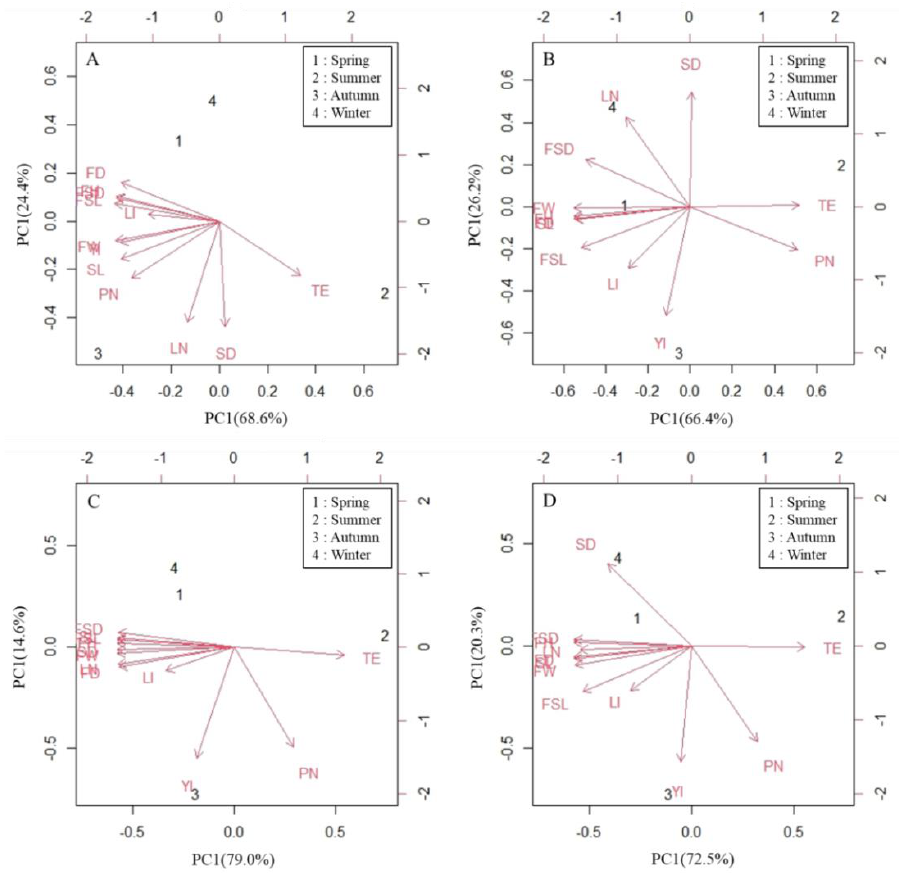
Figure 2. Biplot for the principal component analysis (PCA) of yield and growth on grafted standard type rose Rosa hybrida cv. Pink Beauty in four seasons by rootstock type based on the data in Table 1 with the four seasons being identified by numbers 1 to 4 and yield and growth parameter being identified by abbreviation. ( A ): cutting ( Rosa hybrida cv. Pink Beauty); ( B ): Rosa hybrida cv. Pink Beauty (PB) grafted onto rootstock of Rosa multiflora cv. Hort. No. 1 (N1) (PB/N1); ( C ): PB grafted onto rootstock of Rosa canina cv. Natal brier (NA) (PB/NA); ( D ): PB grafted onto rootstock of Rosa indica cv. Major (RI) (PB/RI). FD: flower diameter; FH: flower height; FSD: diameter of flower neck; FSL: length of flower neck; FW: fresh weight; LI: light intensity; LN: no. of leaves; PN: no. of